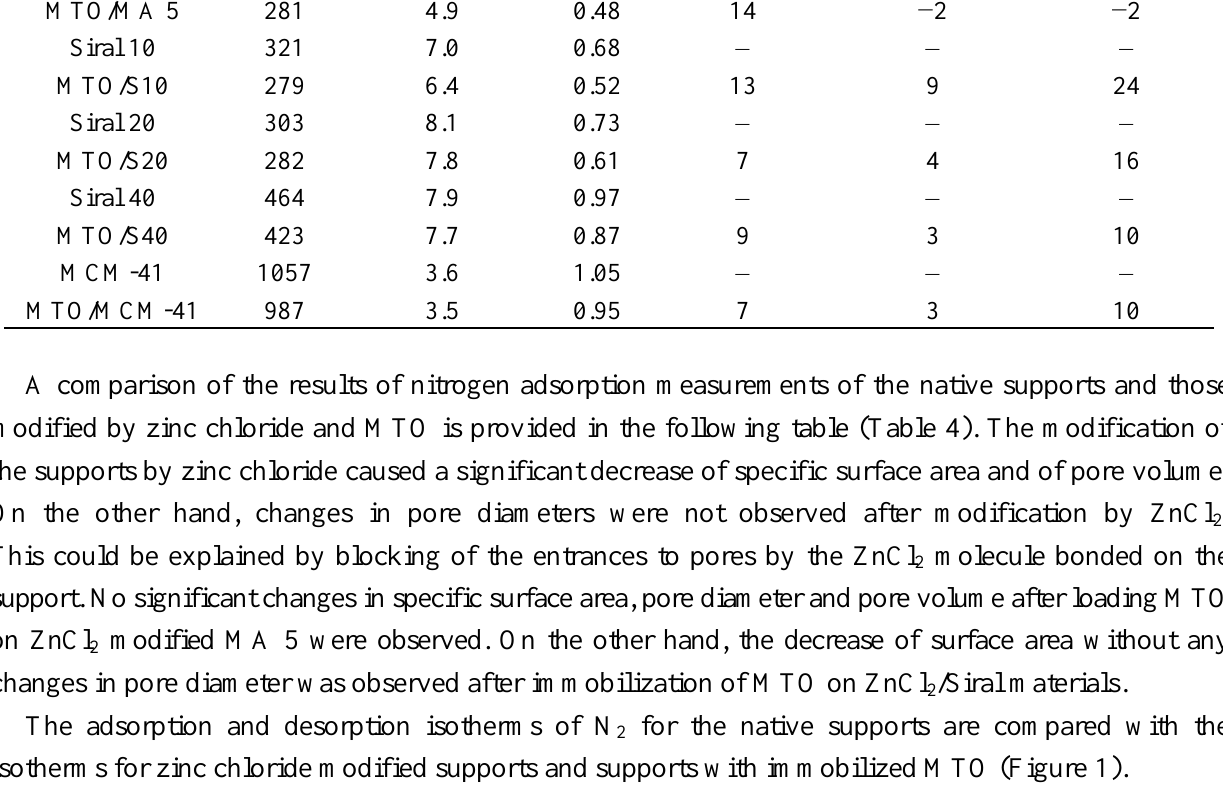
Table 4. Main textural characteristics of native supports and those modified with zinc chloride and MTO (immobilized amount of MTO was 5 mg on 100 mg of supports).